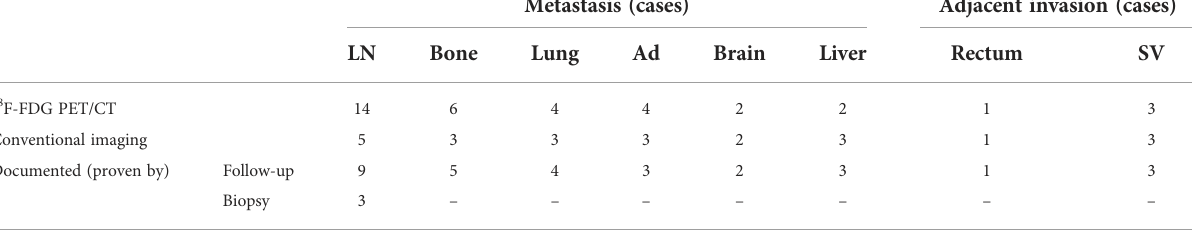
TABLE 2 Metastases and adjacent invasion of patients with synchronous multiple primary malignant neoplasms occurring at the same time